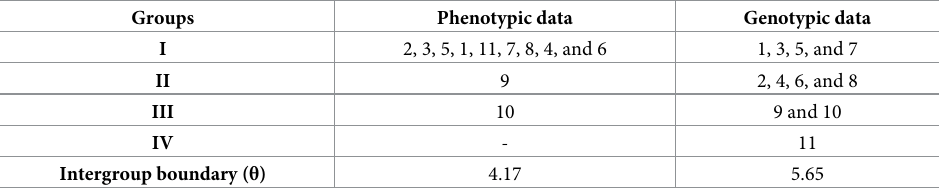
Table 10. Genotype groups established using the Tocher method based on generalized mahalanobis distances (phenotypic and genotypic data).